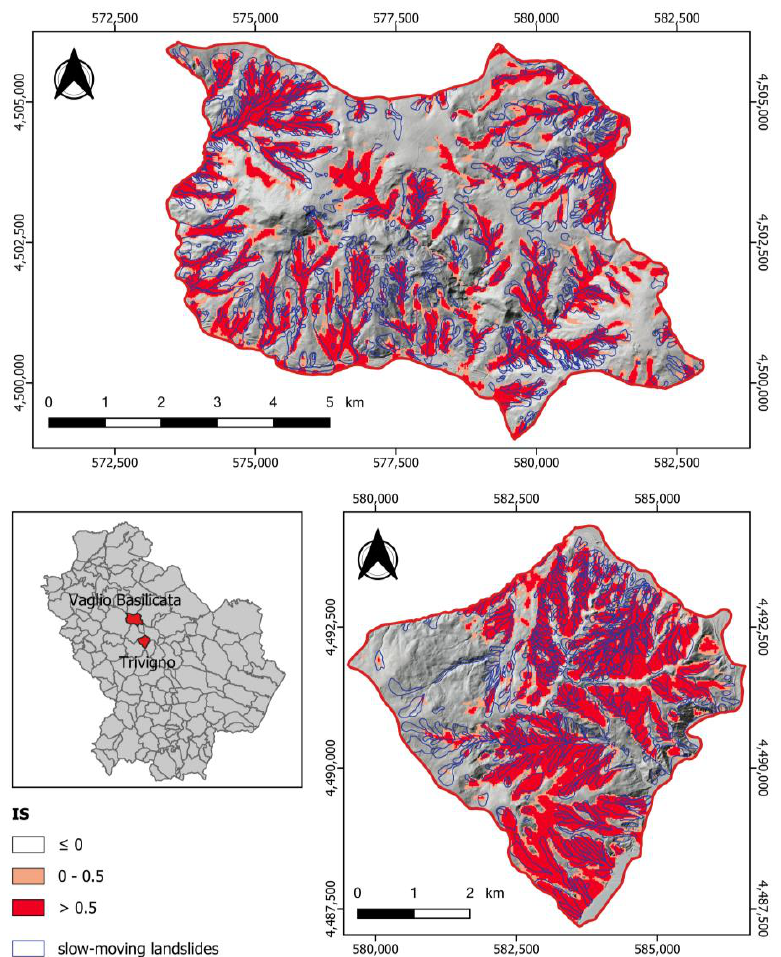
Figure 4. Landslide susceptibility maps at the municipal scale defined employing focal statistics techniques with characteristic dimension equal to 7. Slow-moving landslides recorded in the two test areas are also reported. The inset shows the location of the two municipalities within the Basilicata region.